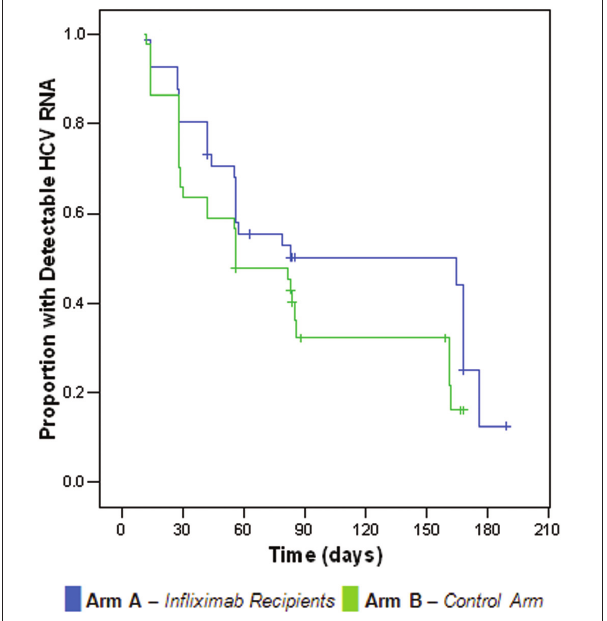
Figure 2) Time to undetectable hepatitis C virus (HCV) RNA levels – inten- tion to treat. Following the initiation of HCV antiviral therapy, the slope of HCV RNA decay was similar between groups. The mean time to undetectable HCV RNA was 109 days (95% CI 88 to 130 days) in infliximab recipients and 83 days (95% CI 64 to 101 days) in the control group (P=0.22)